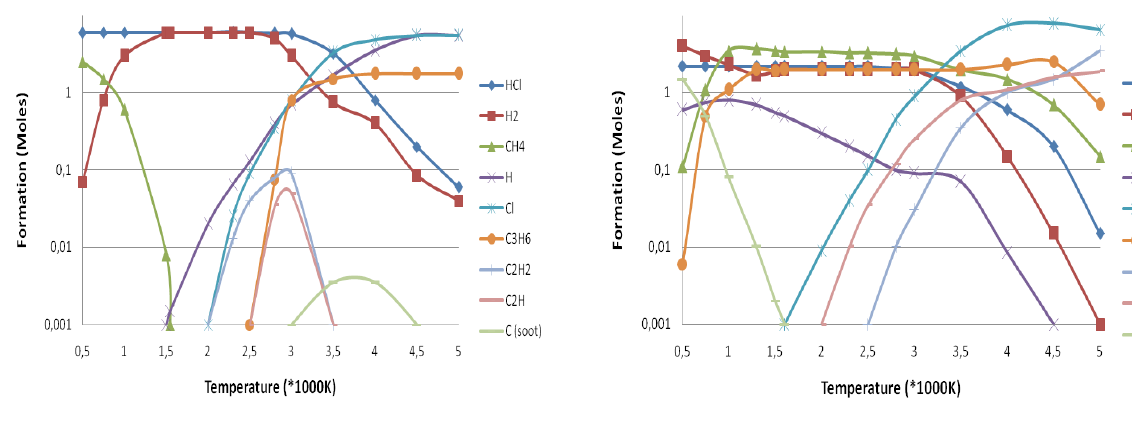
Figure 2 : Pyrolytical decomposition and reaction with water of CH